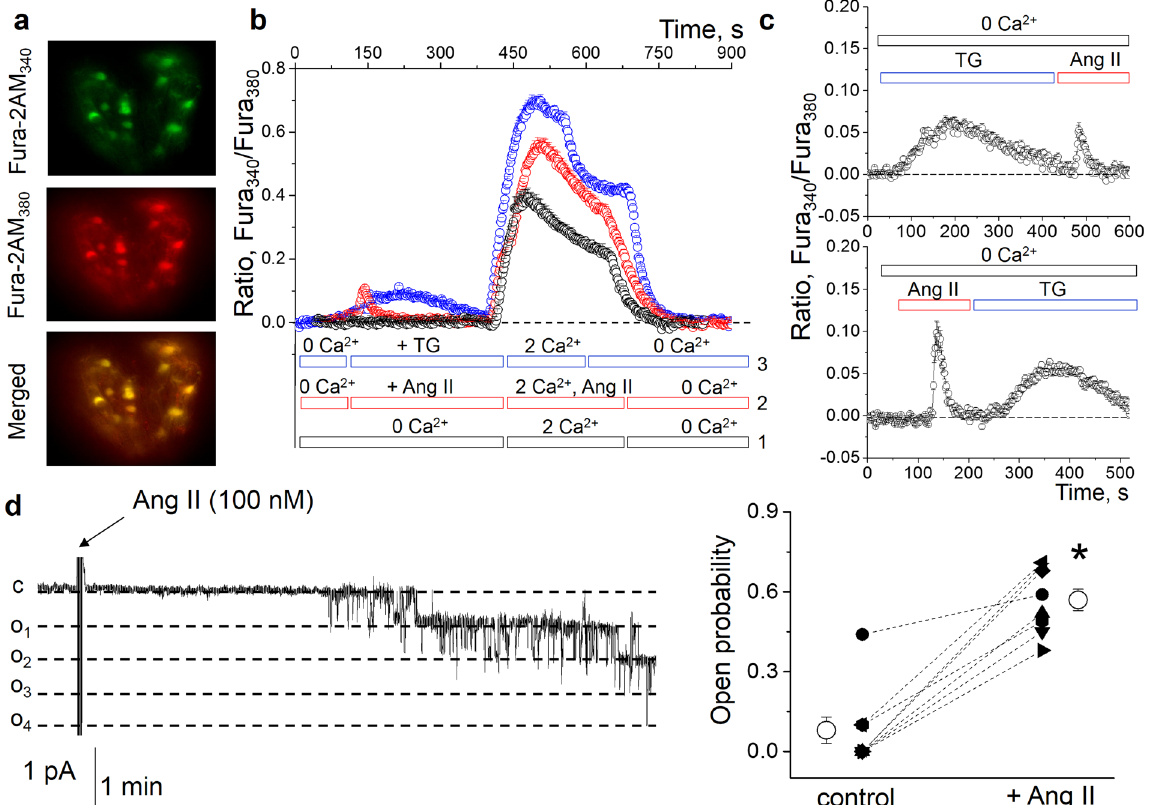
Figure 4. Ang II evokes [Ca 2 + ] i elevation and activates TRPC channels in the podocytes of the freshly isolated rat glomeruli. ( a ) Images of the Fura-2AM-loaded glomeruli obtained by fluorescence microscopy (examples of the fluorescence signals at 340 and 380 nm, and an image merged with brightfield view are shown). ( b ) Representative time course of the changes in [Ca 2 + ] i determined in podocytes of the freshly isolated glomeruli by the ratio of Fura 340 /Fura 380 fluorescence, under three different conditions: (1) modulations in [Ca 2 + ] i induced by changes of medium containing 0 to medium with 2 mM Ca 2 + (black values); (2) medium containing 0 or 2 mM Ca 2 supplemented with 1 μ M Ang II (red values); and (3) medium containing 10 μ M thapsigargin (TG, as shown; blue values). Please note a transient in response to Ang II in Ca 2 + -free media (associated with store depletion). N = 4 animals per group. ( c ) Ang II-stimulated [Ca 2 + ] i peak is inhibited after calcium store depletion with TG. Shown is a [Ca 2 + ] i response after depletion of the intracellular store with TG and consecutive treatment with Ang II, and a reverse experiment. ( d ) Representative continuous current trace from a cell-attached patch containing endogenous TRPC channels. Arrow demonstrates addition of Ang II (100 nM) to the external bath solution. The patch was held at a − 60 mV test potential during the course of experiment. The c and o i denote closed and open current levels, respectively. Right panel shows a summary graph for the channels’ open probability ( P o ) before and after application of Ang II. * P < 0.05 versus before Ang